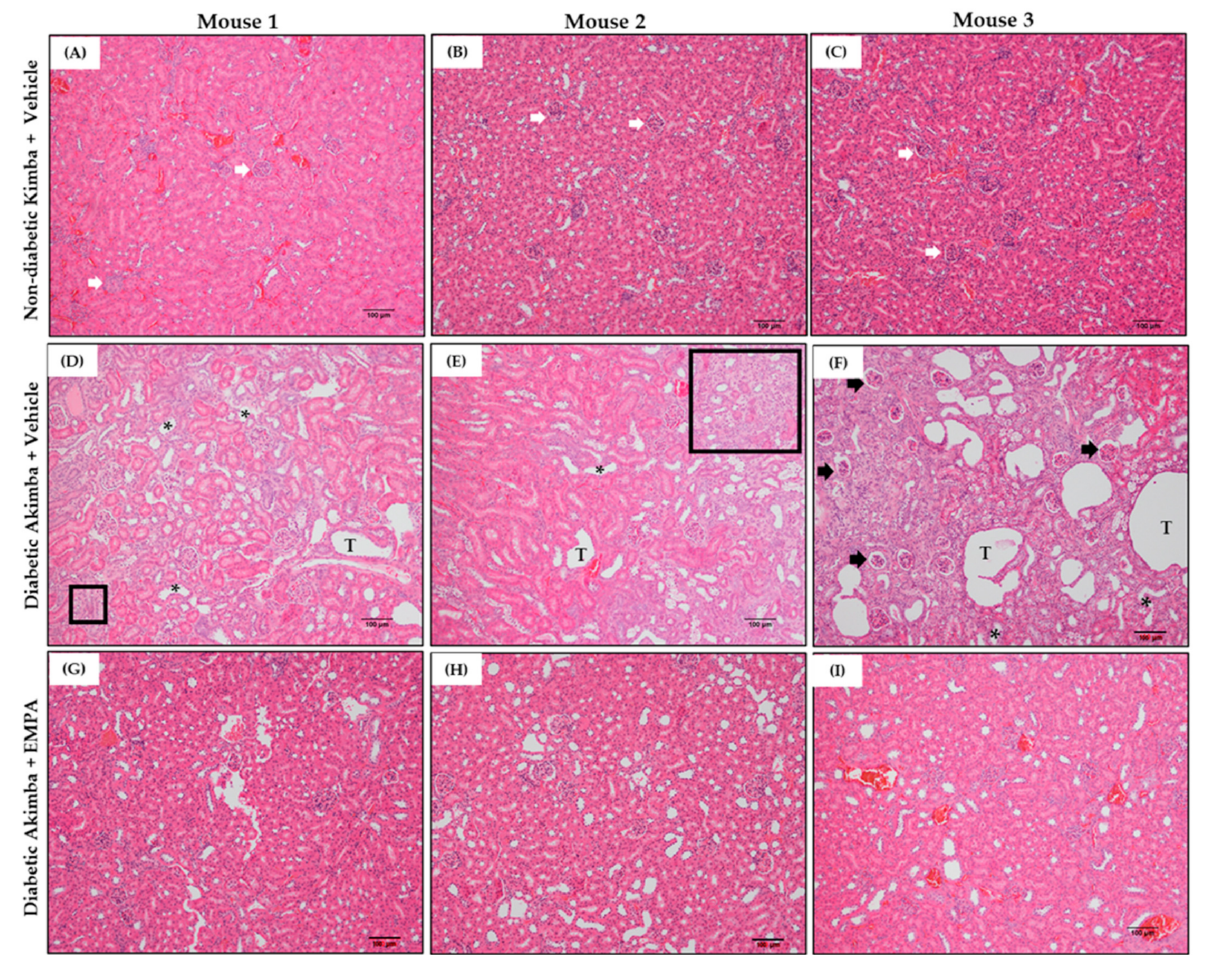
Figure 9. Representative images of H&E-stained kidney tissues from non-diabetic Kimba mice treated with Vehicle ( A – C ), diabetic Akimba mice treated with Vehicle ( D – F ) and diabetic Akimba mice treated with EMPA ( G – I ). Glomeruli ( A – C ; white arrows), tubular dilation ( D – F ; black asterisks), degeneration, and vacuolation of renal tubules ( D – F ; letter T ), tubulointerstitial fibrosis ( E ; black box) and shrunken glomeruli with wide Bowman’s spaces ( F ; black arrows) are shown. Scale bar = 100 µ m; Magnification = 100 × ; representative images are shown for 3 mice/group. EMPA: